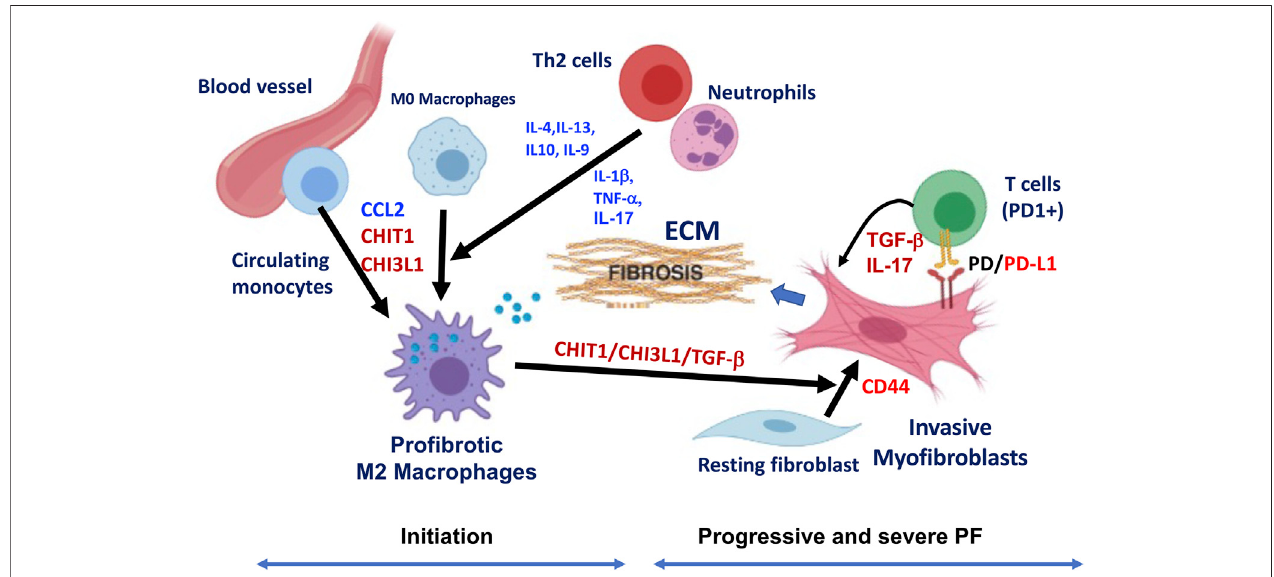
FIGURE 3 | Schematic illustration of hypothetical pathway leading to the development of pro fi brotic macrophages and invasive fi broblasts in the pathogenesis of pulmonary fi brosis (PF). Although multiple cells and mediators are involved in this process, implication of CHIT1/CHI3L1 and PD-1/PD-L1 axis are highlighted as major playersin thedevelopmentof pro fi brotic macrophages and invasive fi broblasts/myo fi broblasts leadingto progressive and severe pulmonary fi brosis throughsuggested heterocellular interactions. As indicated, fi brotic macrophages are recruited from the circulatory monocytes potentially through CCL2, CHIT1 or CHI3L1 then develops to alternatively activated pro fi brotic macrophages that highly expressing CHIT1, CHI3L1 and TGF- β . These mediators synergistically interact to transform resting fi broblasts to myo fi broblasts with invasive nature through CD44. PD-L1 expressing invasive fi broblasts interact with PD-1 (+) T cells that further induce the pro fi broticmediatorsincludingTGF- β andIL-17,thatresultedinto fi brotictissueresponsewithexcessiveextracellularmatrix(ECM)accumulation.Th2cytokines(IL-4,IL- 13,IL-10,andIL-9)andproin fl ammatorycytokines(IL-1 β ,TNF- α ,andIL-17)fromTH2cellsandneutrophilscanalsocontributetopro fi broticmacrophageactivationand subsequent fi broblasts proliferation and activation leading to pulmonary fi brosis ( The image is created with BioRender.com ).